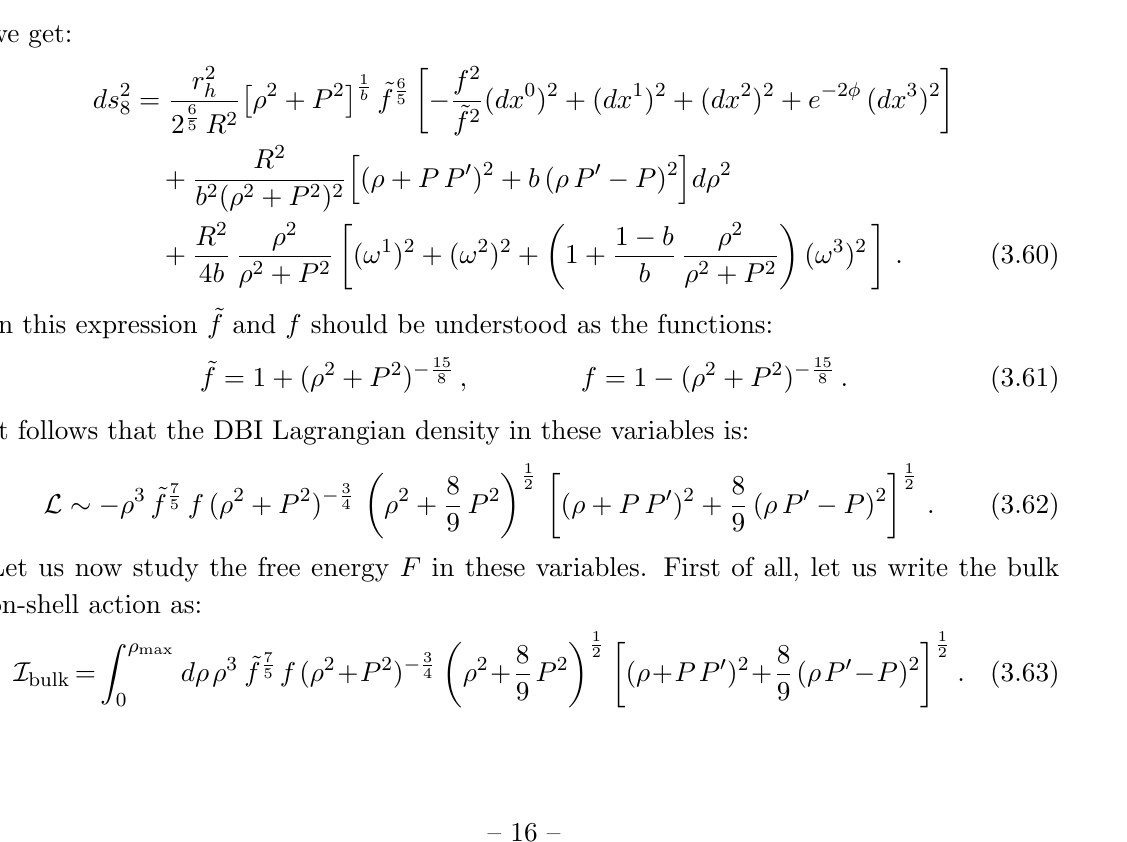
Figure 2 . In these plots we represent the free energy density, internal energy density, and entropy density as a function of m (cid:0) 1 b (cid:24) T . Notice that the normalization factor m 4 b N is independent of the temperature. The continuous black (blue) curve corresponds to black hole (Minkowski) embeddings. Near the transition point the expected swallowtail behavior is obtained. The dashed curves are the result of the analytic high temperature calculation of appendix